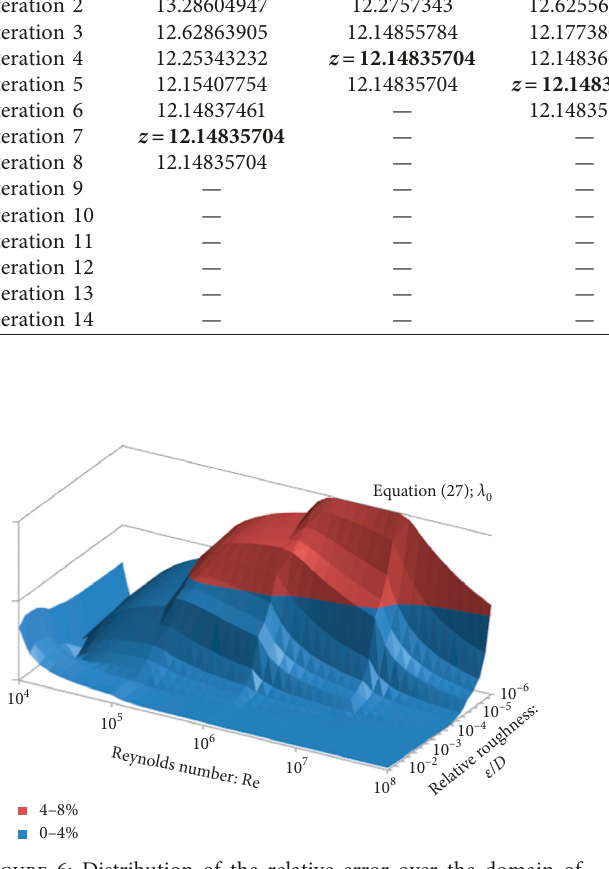
Figure 8: Distribution of the relative error over the domain of applicability of the Colebrook equation of the approximation, Equation (28); for i 1, the maximal relative error is (cid:31)